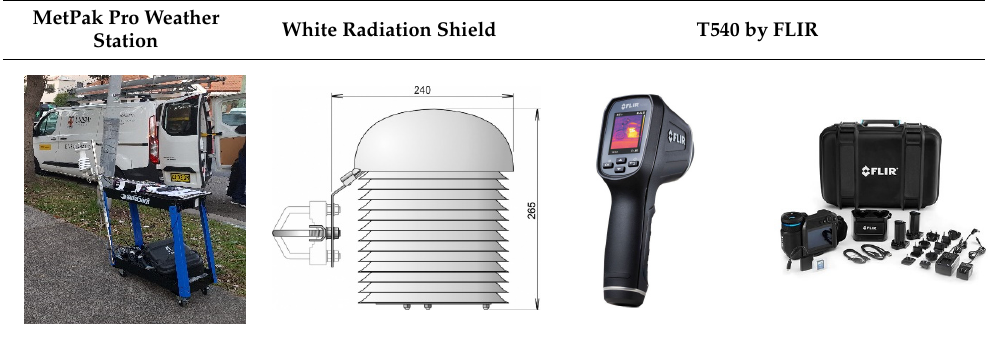
Table 6. The MetPak Pro cart-mounted weather station used for spot measurements in tracks on the left and the white radiation shield and TG54 infrared thermometers integrated on the cart, respectively, in the middle and right.